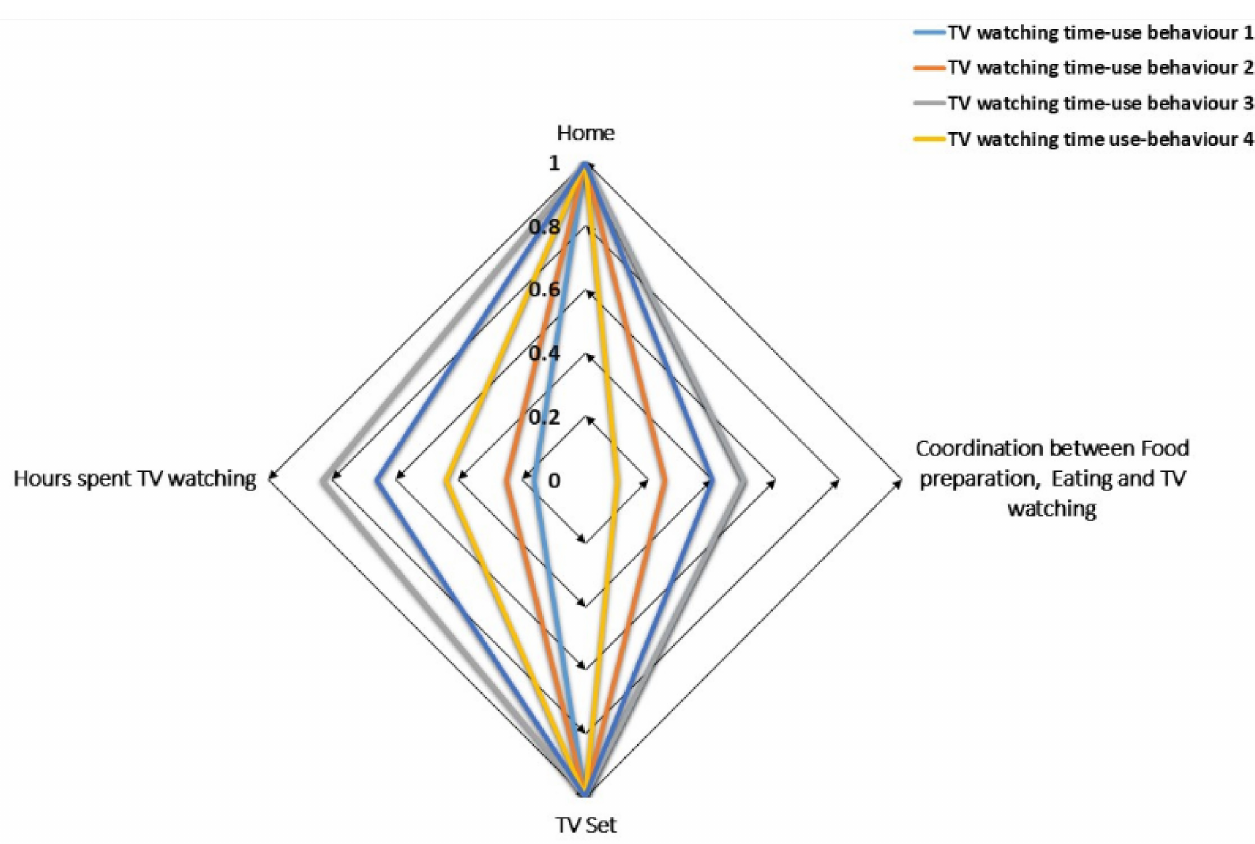
Figure 2. Example of four different TV watching time-use behaviours (based on UKTUS 2014/15 data).